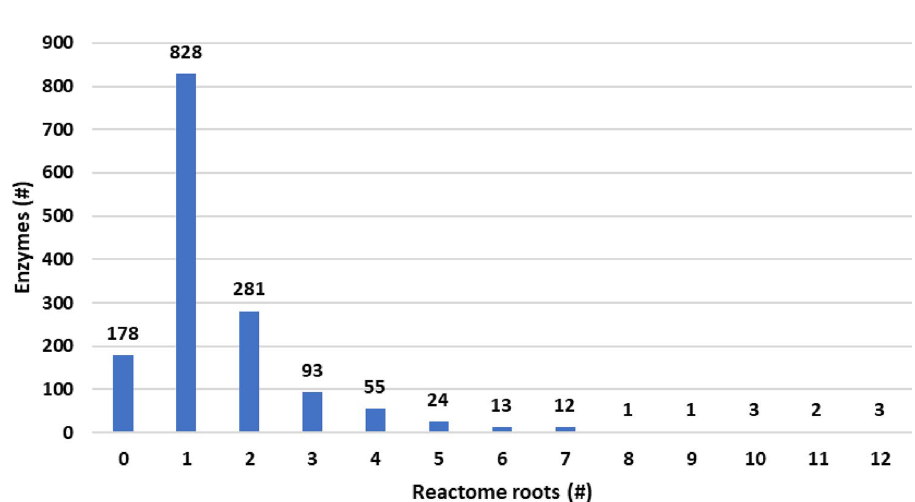
Figure 2. Distribution of enzymes according to the number of Reactome roots they belong to. #: number of. The number of enzymes in each group is reported at the top of each bar. Roots “Disease” (R-HSA-1643685) and "Drug ADME" (R-HSA-9748784) are not considered. Enzymes associated to 12 different Reactome roots are three subunits of the proteasome (Proteasome subunit beta type-10, P40306; Proteasome subunit beta type-9, P28065; Proteasome subunit beta type-8,